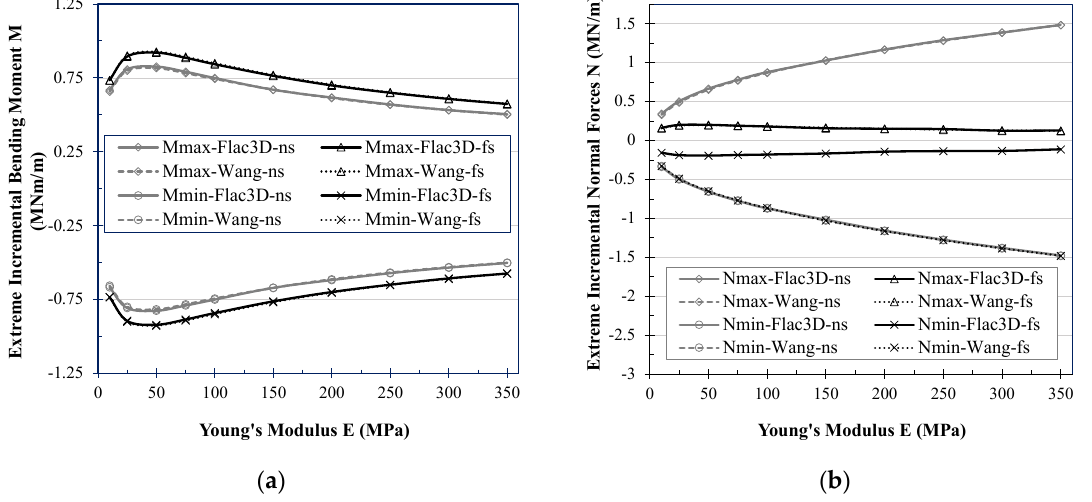
Figure 6. Effect of E on the incremental internal forces of the circular tunnel lining. ( a ) Extreme incremental bending moments; ( b ) extreme incremental normal forces.